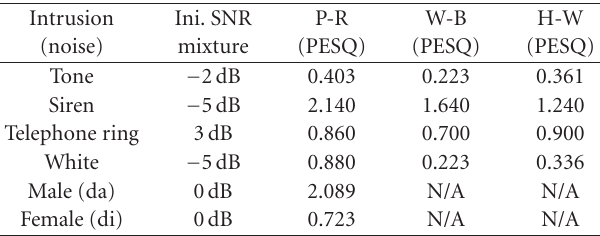
Table 1: PESQ for three di ff erent methods: P-R (our proposed ap- proach), W-B [7], and H-W [8]. The intrusion noises are (a) 1kHz